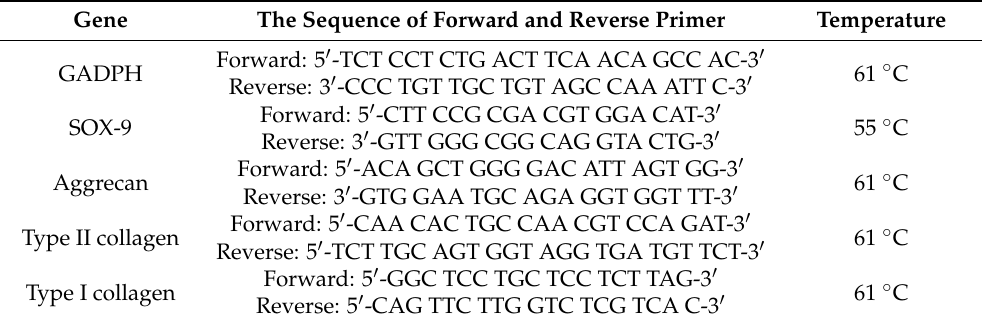
Table 1. Reverse and forward primer sequences and annealing temperature are used for